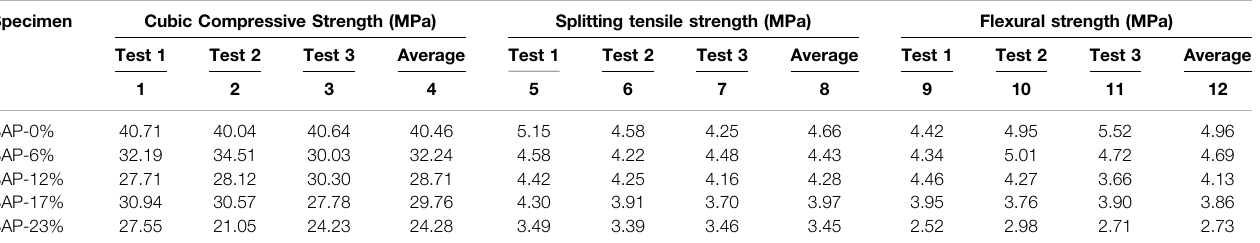
TABLE 4 | Compressive, splitting tensile and fl exural strength of SAP concrete at different mixing proportions. Specimen Cubic Compressive Strength (MPa) Splitting tensile strength (MPa) Flexural strength (MPa)